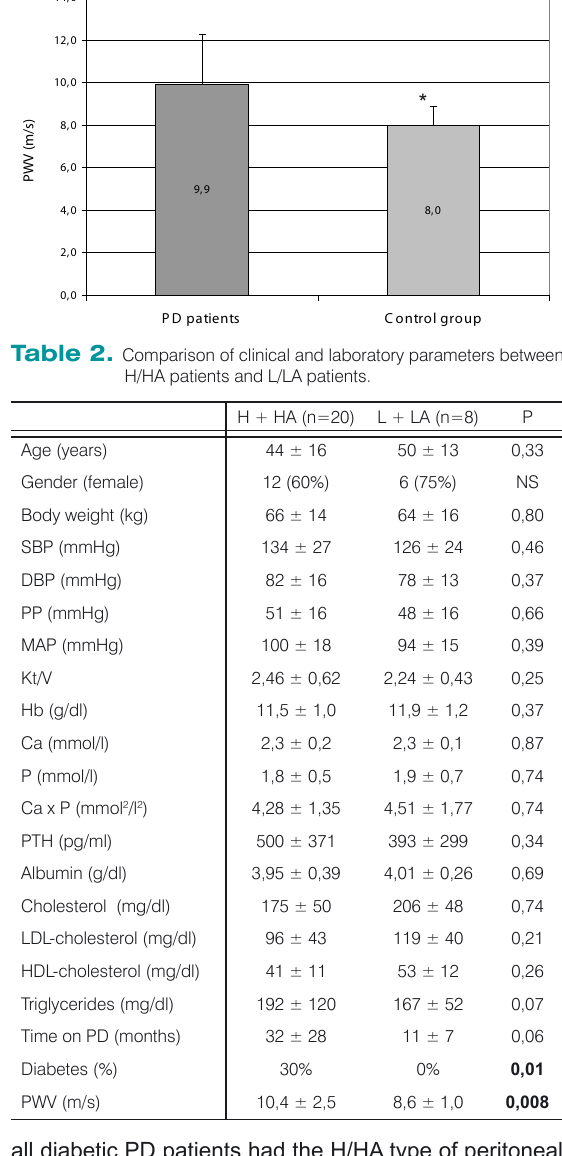
Figure 1. Comparison of carotid-femoral pulse wave velocity in peritoneal dialysis patients and control group (* p = 0,0004).